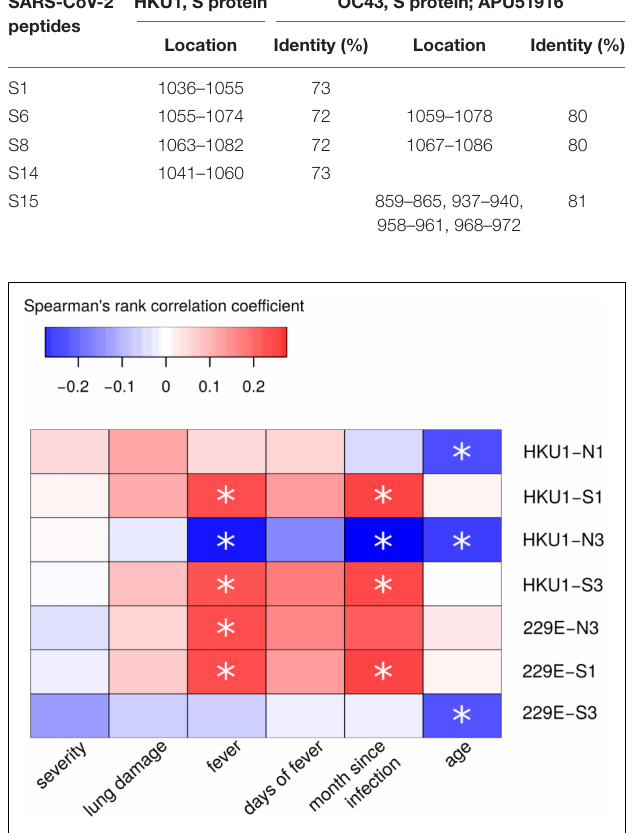
FIGURE 8 | Correlation analysis of COVID-19 serum reactivity with eCoV peptides and demographic and clinical COVID-19. Spearman’s rank test was used to analyze correlation between reactivity with eCoV peptides and clinical presentation and characteristics of patients. Asterisks indicate statistically significant correlations ( p < 0.05 with Benjamini-Hochberg